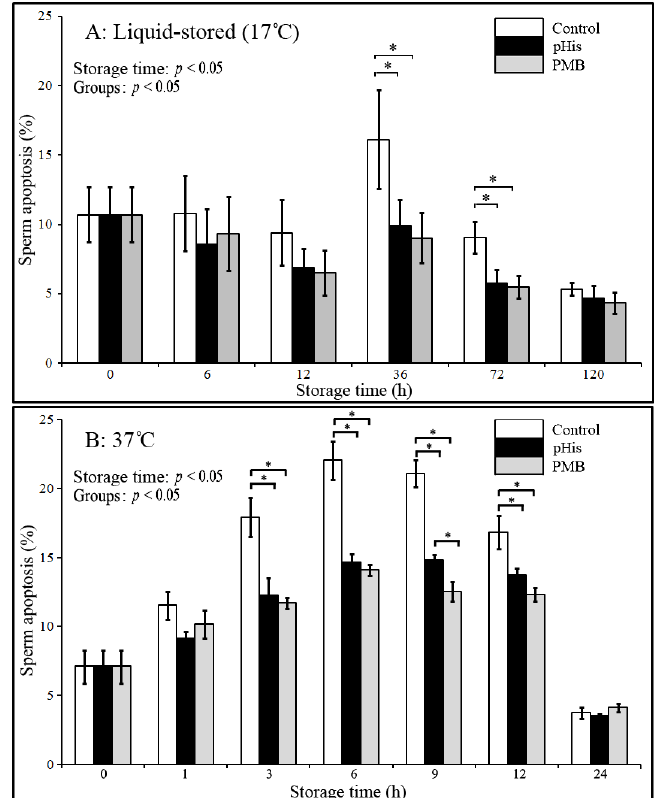
Figure 4. Changes in sperm apoptosis during liquid storage (17 °C) and at 37 °C incubation. * indicates a significant difference ( p < 0.05). Boar sperm were diluted with BTS extender in the control group, and 100 μg /mL PMB or pHis was added in the BTS extender in PMB or pHis groups.